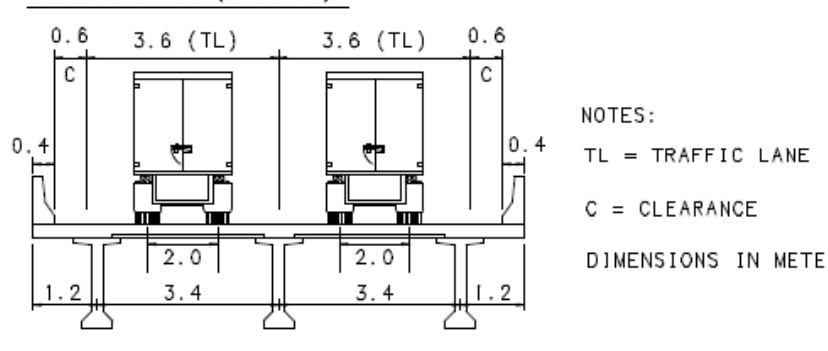
Figure 9. Bridge